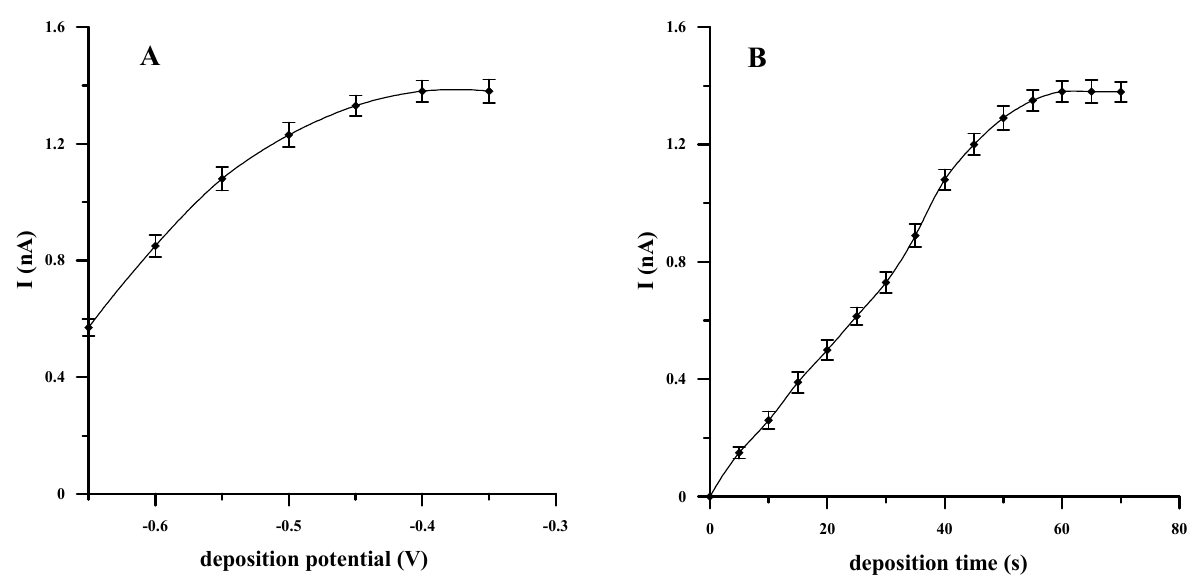
Figure 3. The effect of the accumulation potential ( A ) and its time ( B ) on the AdSV voltammetric response of V(V). Fixed concentration: 1 × 10 -8 mol L -1 V(V), 0.1 mol L -1 acetate buffer (pH = 4.6) and response of V(V). Fixed concentration: 1 × 10 − 8 mol L − 1 V(V), 0.1 mol L − 1 acetate buffer (pH = 4.6) 1 × 10 − 3 mol L -1 cupferron. and 1 × 10 − 3 mol L − 1